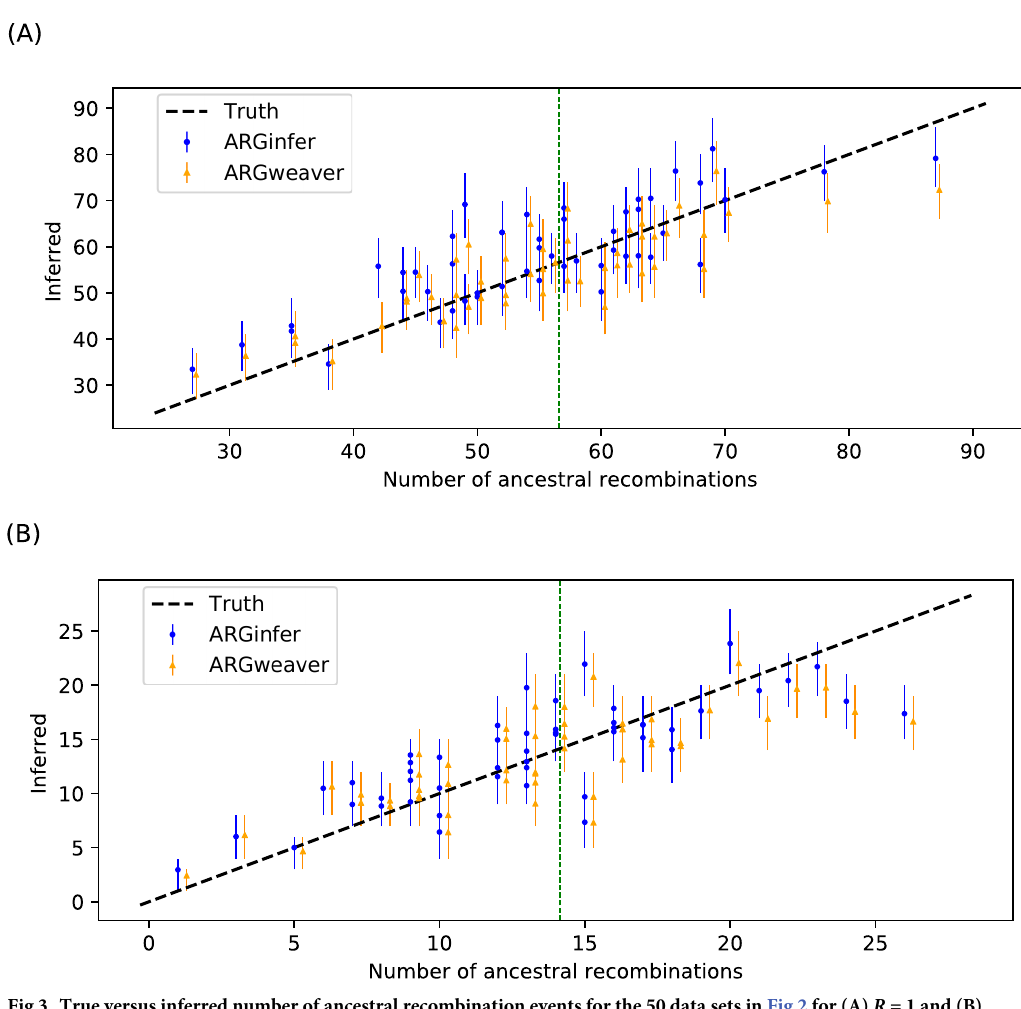
Fig 3. True versus inferred number of ancestral recombination events for the 50 data sets in Fig 2 for (A) R = 1 and (B) R = 4. The vertical line segments are 50% credible intervals. The green vertical line indicates the prior mean.